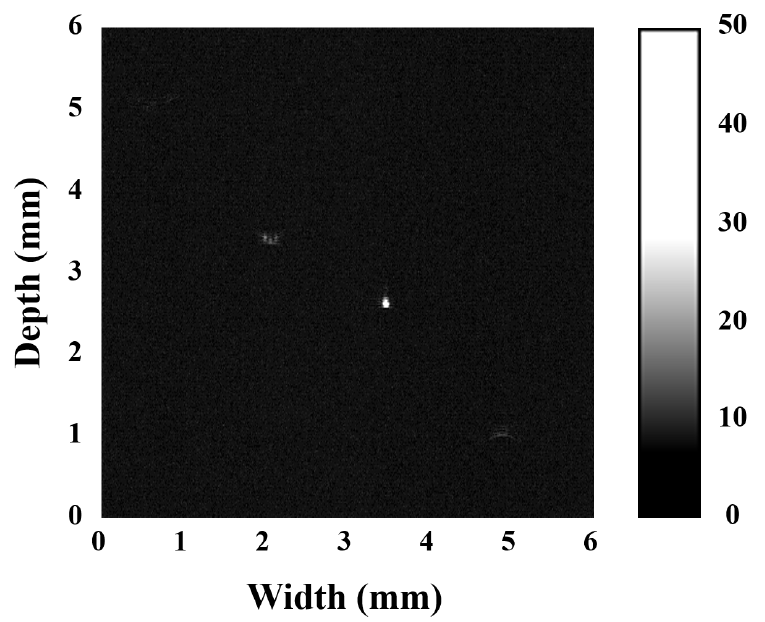
Figure 7. Wire phantom UBM images obtained by the 37 MHz NBT-Nb-Mn single element transducer.